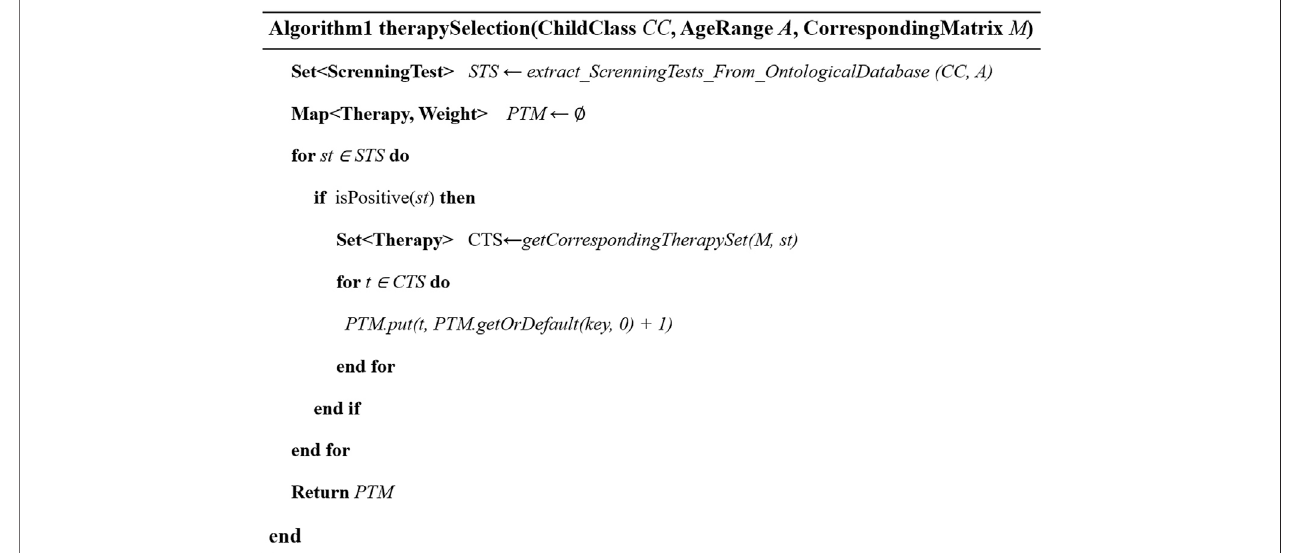
FIGURE 5 | Therapy selection algorithm.